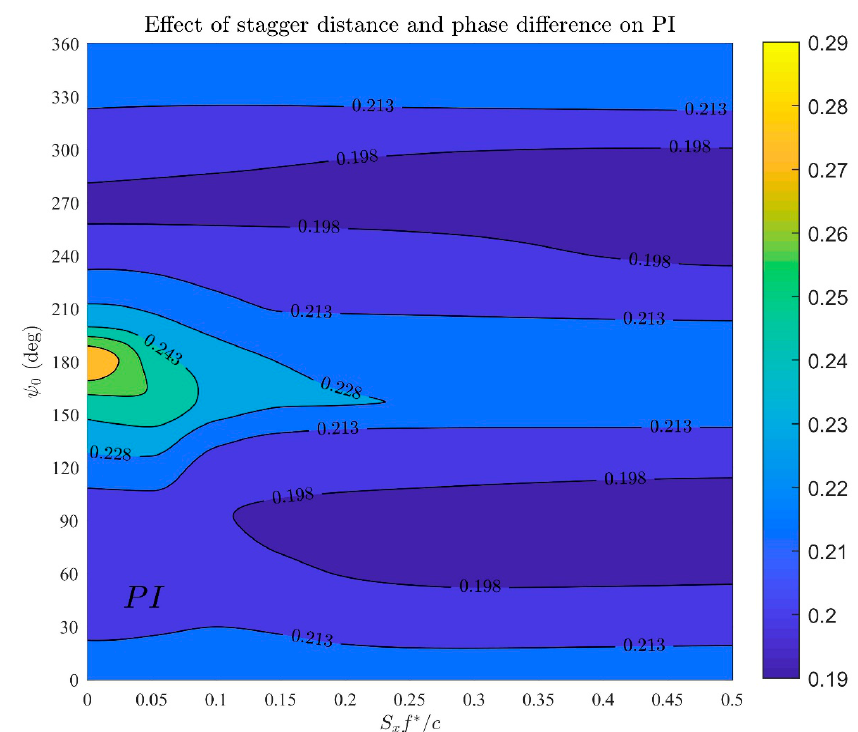
Figure 16. Performance index of the twin-foil system for the case of S f = 1.8 c . The contours show the performance index of the system for X f ∗ / c = 0 − 0.5 and ψ 0 = 0 o ÷ 360 o .